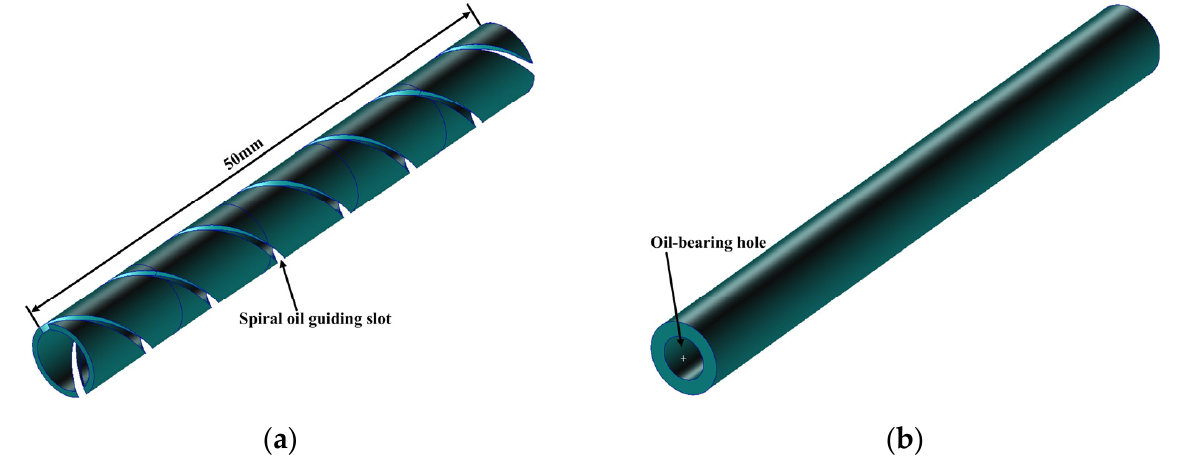
Figure 5. Outer cylinder and inner cylinder of the bolt: ( a ) outer cylinder of the bolt; ( b ) inner cylinder of the bolt.